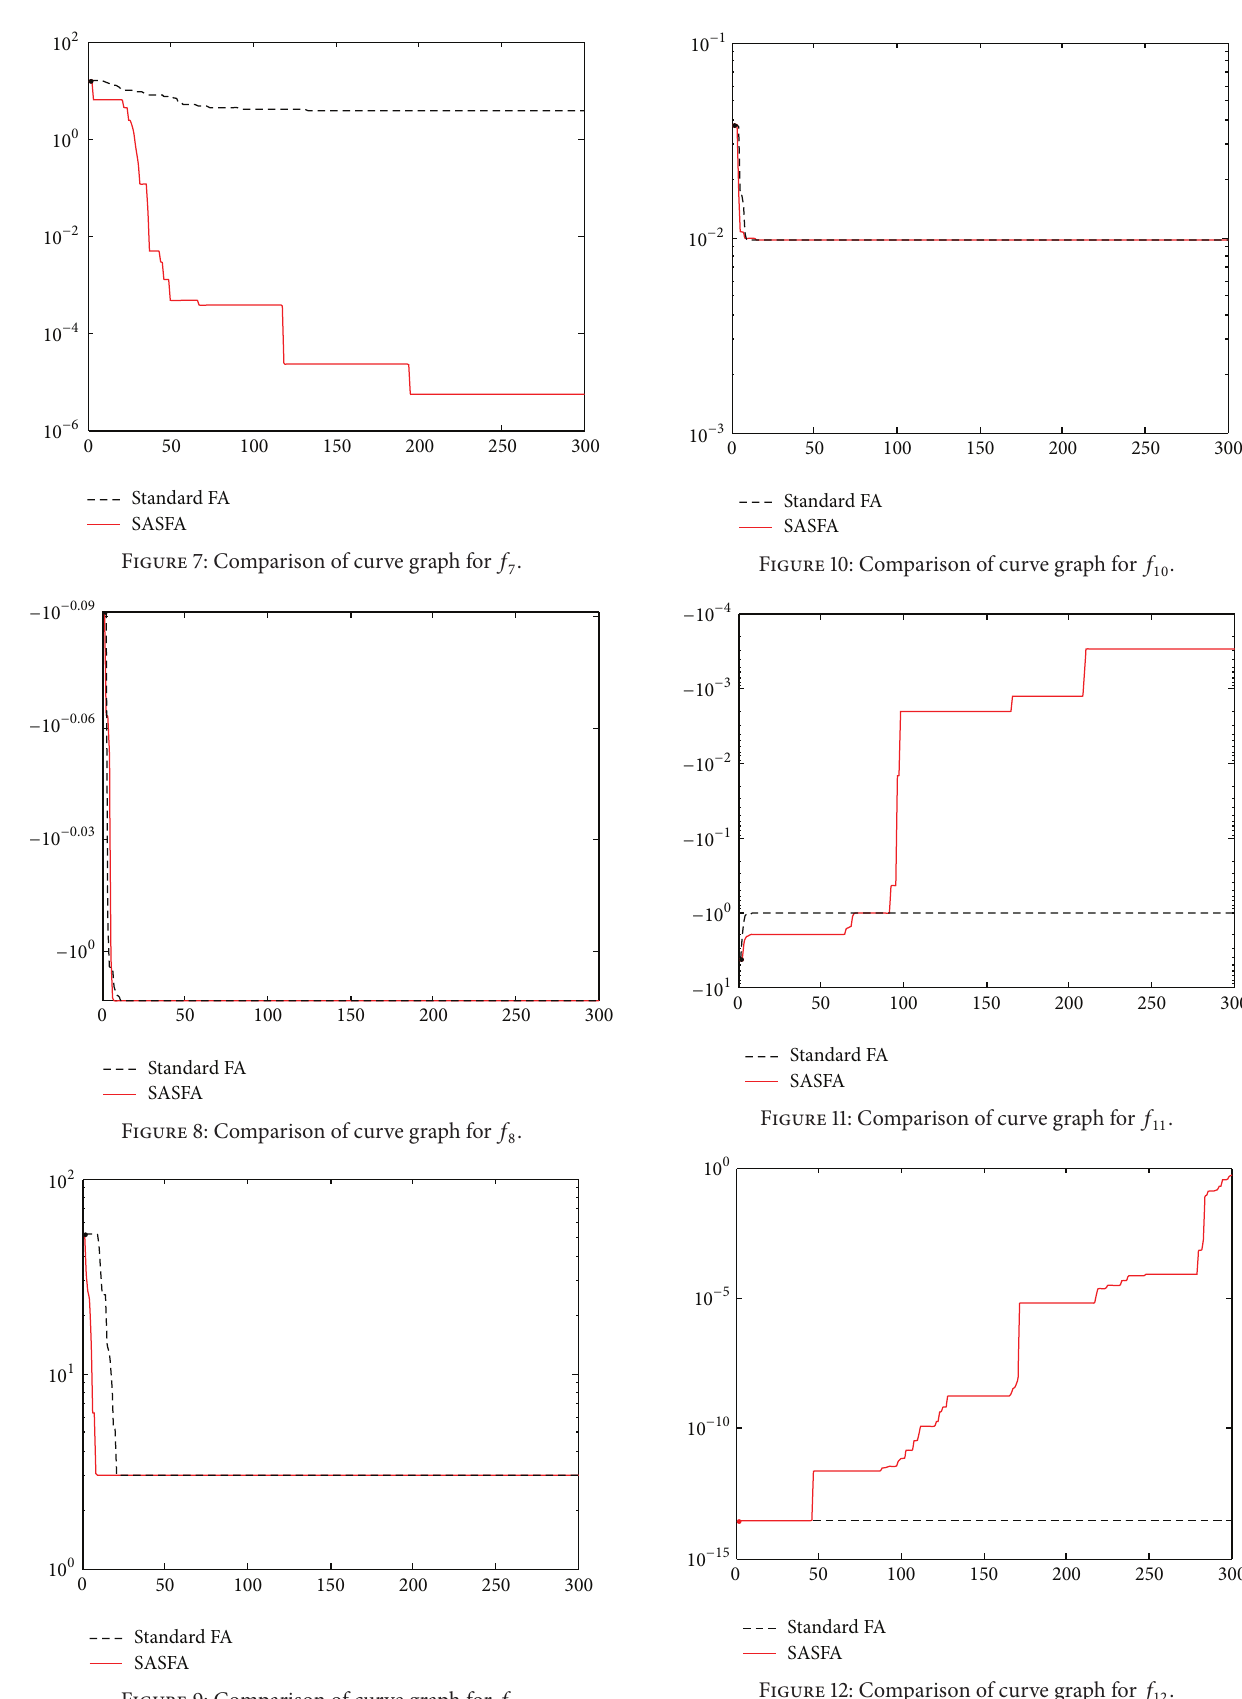
Figure 9: Comparison of curve graph for 𝑓 9 .